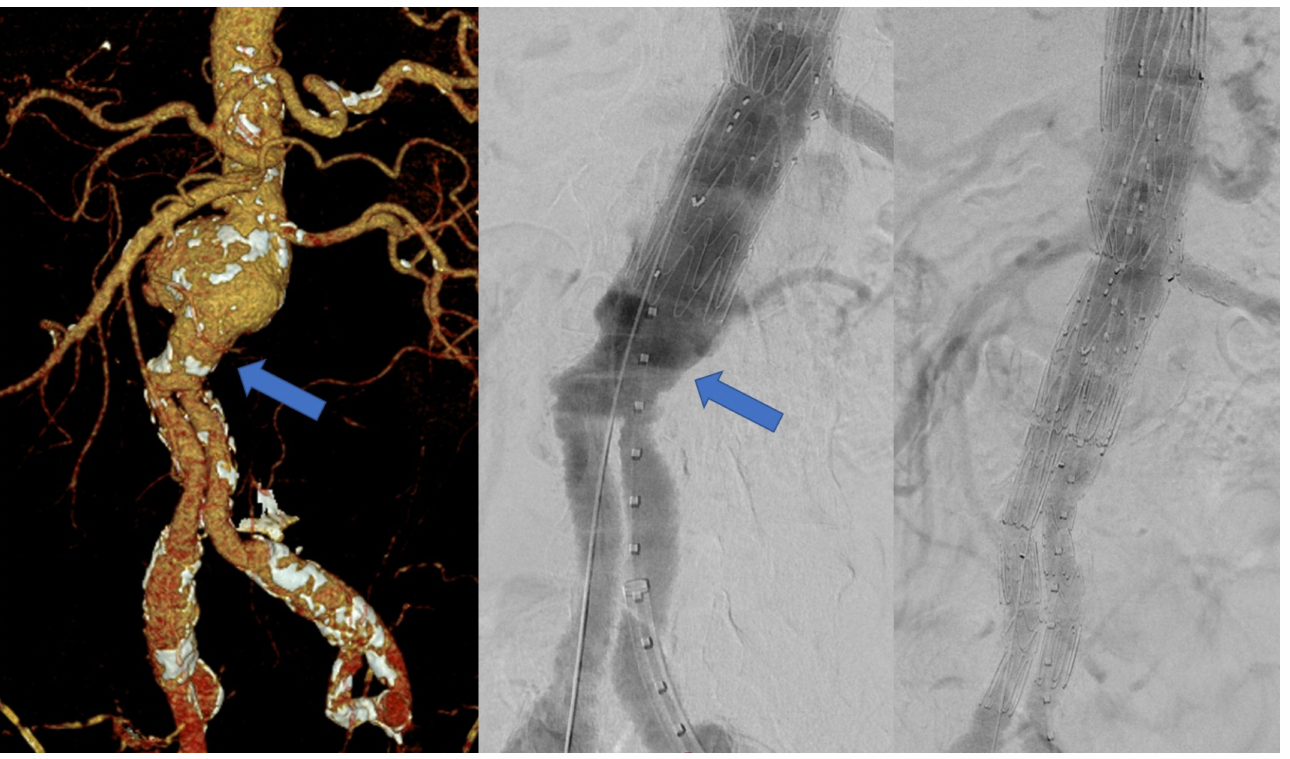
Figure 1. Para-anastomotic aneurysm in a patient with a short body in the previous surgical graft (arrow) and control angiography after treatment with a fenestrated stent graft and a bifurcated device with an inverted